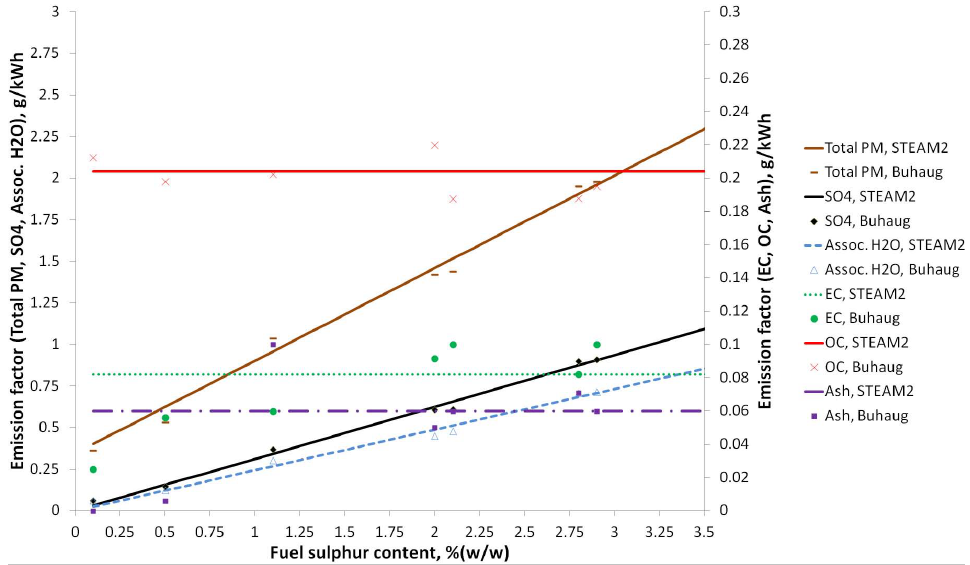
Fig. 3. The emission factor of the total PM, and for its chemical constituents as a function of fuel sulphur content (mass-based percentage), based on the data from the second IMO GHG study (Buhaug et al., 2009). Lines indicate the PM component emission factors in STEAM2. The emission factors of the total PM, SO 4 and H 2 O are linearly dependent on the fuel sulphur content. The scale used for total PM, SO 4 and associated H 2 O is different (left-hand axis) from the scale used for EC, OC and ash (right-hand